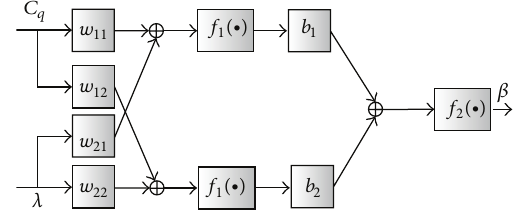
Figure 8: Topology of the 3-level BP neural network.